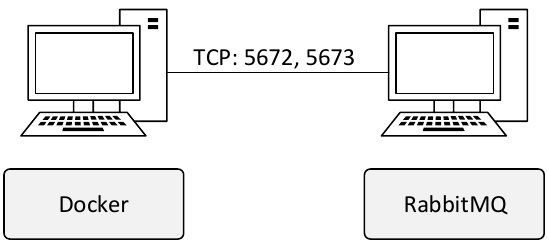
Figure 9. Test environment for several